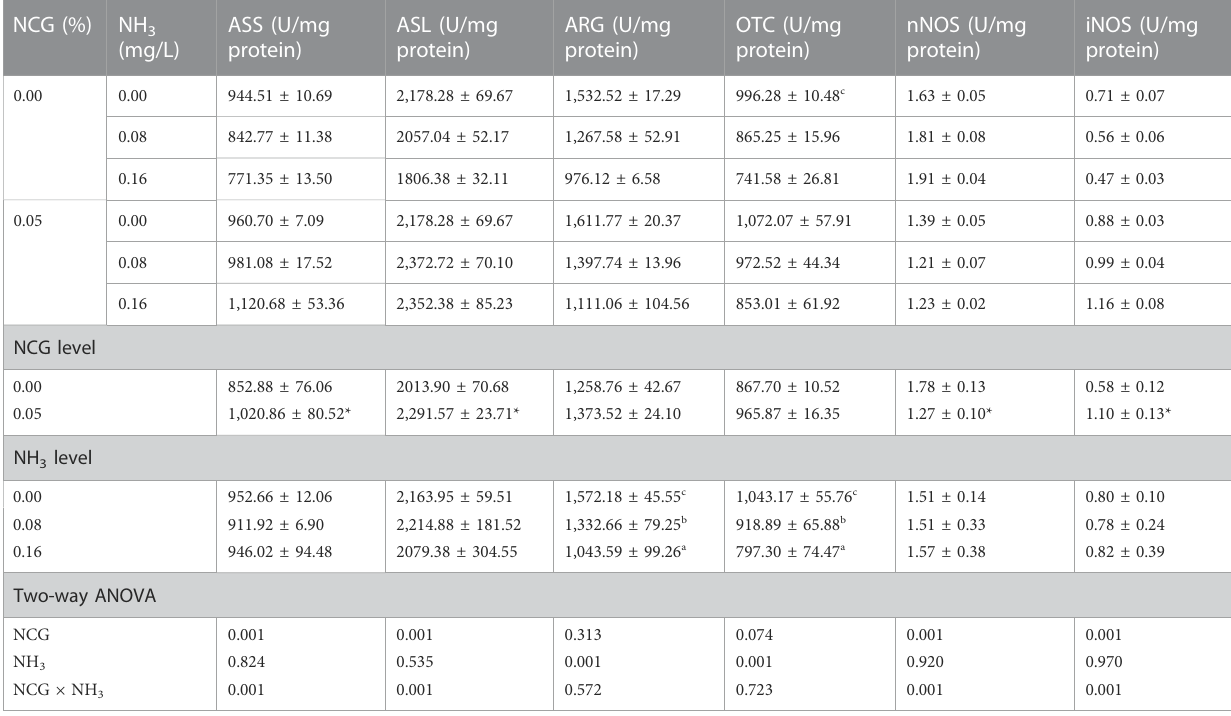
TABLE 8Effects of dietary N -carbamylglutamate supplementationonactivities ofammoniametabolismenzyme andnitricoxide synthase inliver ofyellow cat fi sh exposed to different ammonia levels for 84 days.